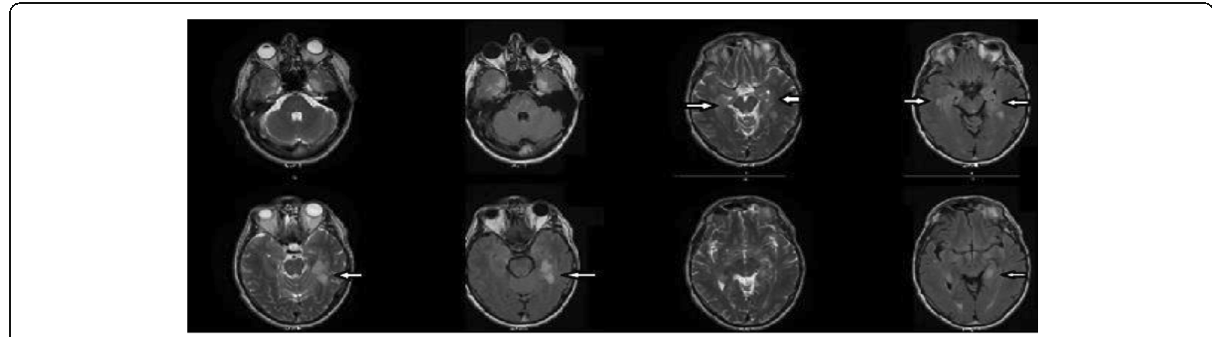
Fig. 2 Post-pacemaker MRI brain 1 month after showing extensive T2 hyper-intensities and signal changes in bilateral hippocampi, anterior sub- temporal regions as two small areas in the left mesial temporal regions. There was a mild degree of swelling in these areas without any restricted diffusion and no contrast